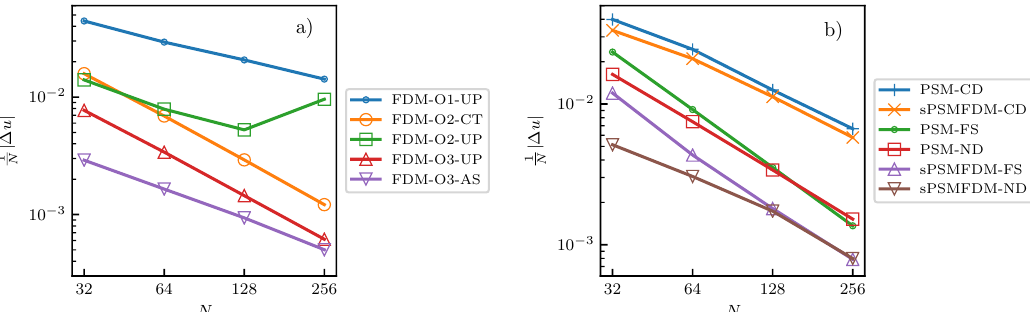
Figure A2. The dependence of the averaged error on the grid number in ( a ) FDM schemes and ( b ) spectral schemes. The finite-difference schemes are compared in ( a ), where FDM means the finite-difference method, O followed by a number means the order of accuracy, UP means upwind scheme, CT means central difference, and AS means adaptive stencil scheme. The spectral schemes are compared in ( b ), where PSM means pseudo-spectral method, sPSMFDM means the hybrid approach of smoothed PSM and FDM, CD means classical 2/3 dealiasing, FS means Fourier smoothing, and ND means no dealiasing is